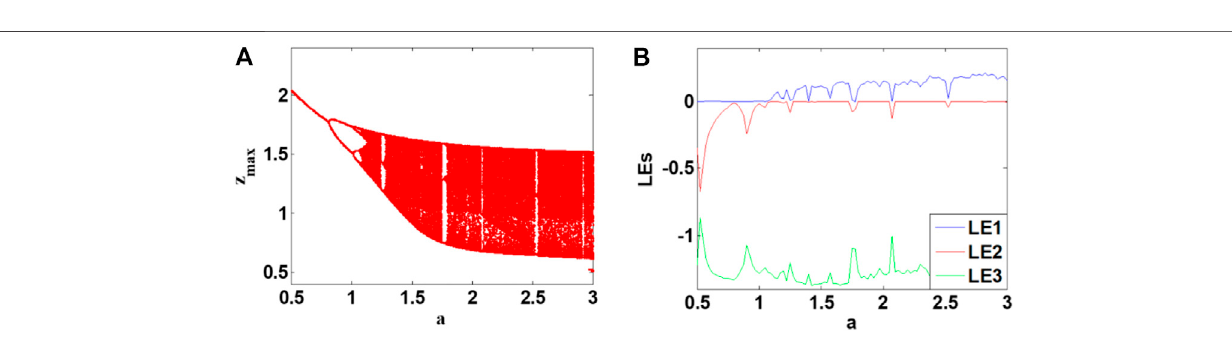
FIGURE 3 | Strange attractor of system (2) with a (cid:1) 2.4, b (cid:1) 0.5, c (cid:1) 1.7, d (cid:1) 2.5 under initial conditions (1, 0, 1) (A) x-y plane, (B) x-z plane.